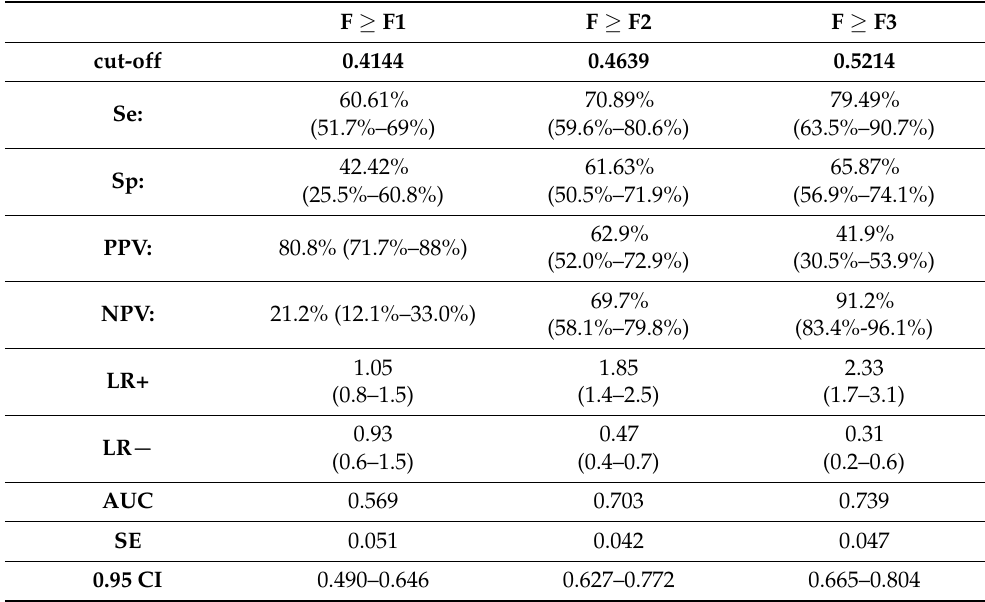
Table 7. The diagnostic performance of APRI for fibrosis grades greater than or equal to 1, greater than or equal to 2, and greater than or equal to 3.